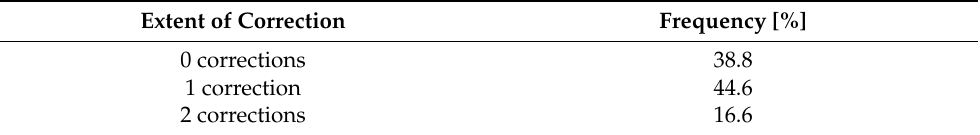
Table 2. Fraction of batches undergoing corrections over the three years of plant operation preceding this